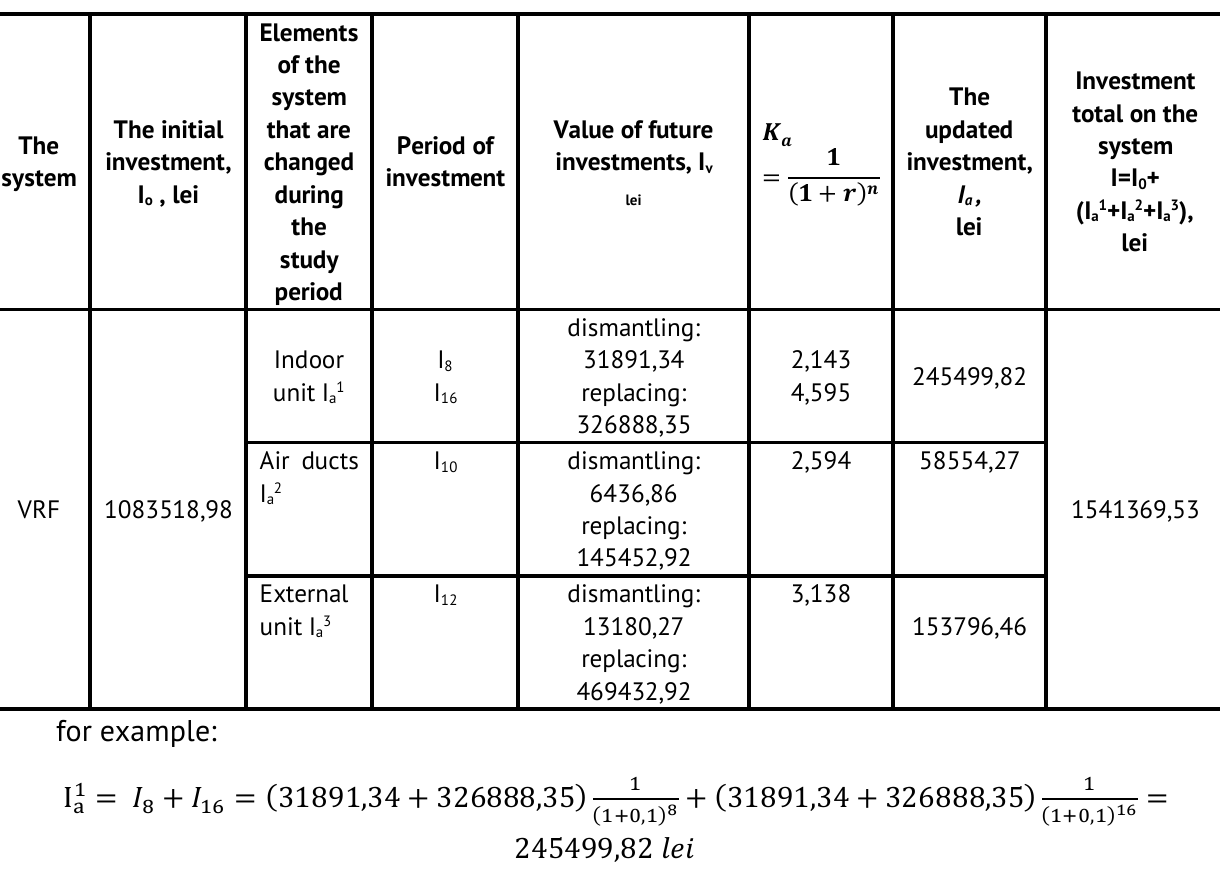
Variant A. Determination of total investments for the VRF system